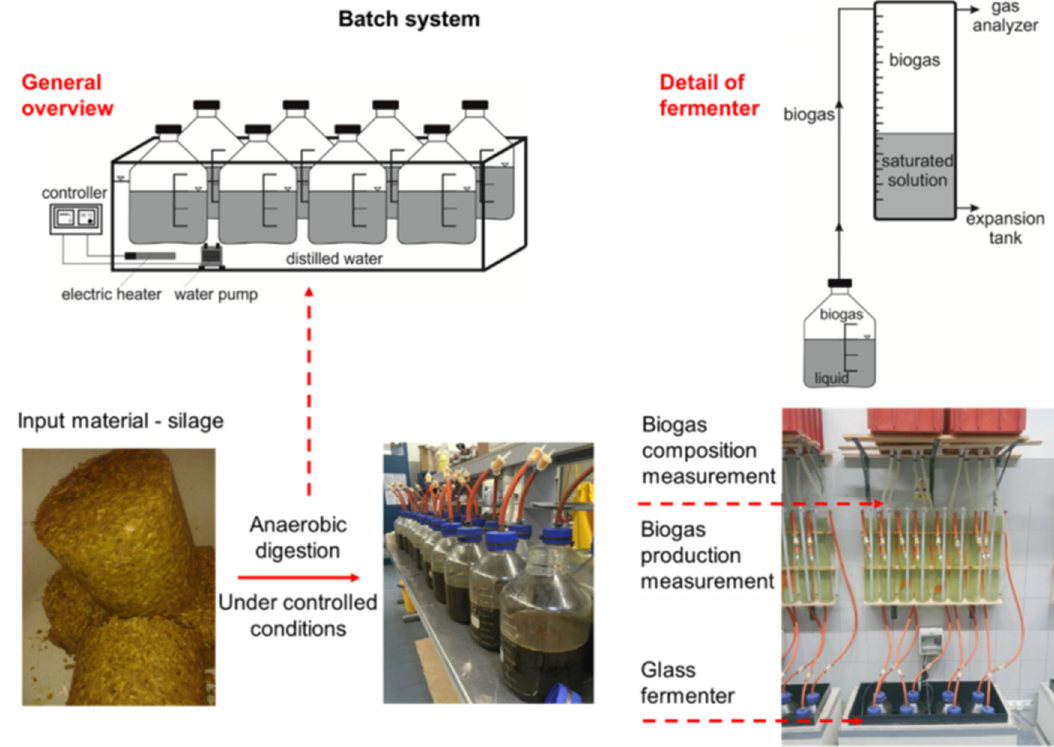
Figure 2. Biochemical methane potential assay design [24].